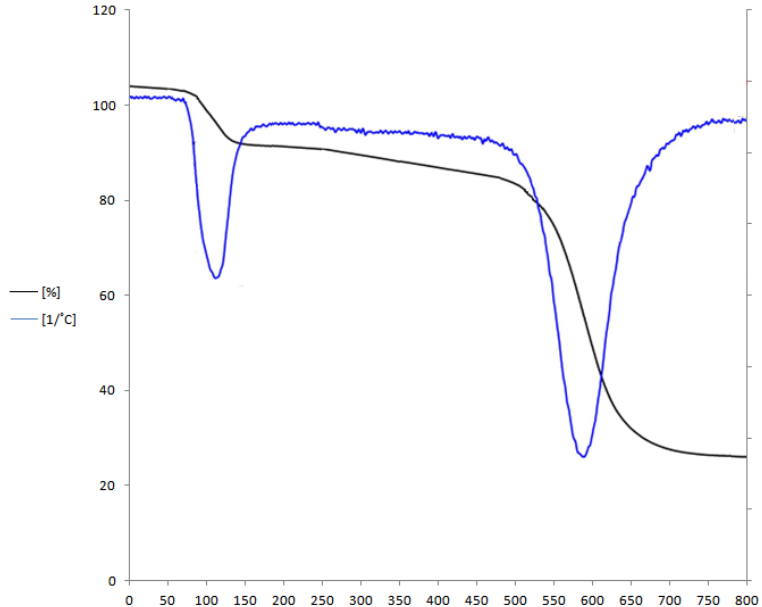
Figure 4. Thermogravimetric analysis/differential thermogravimetric (TGA/DTG) curves corresponding to the PMO-Py material up to 800 °C .